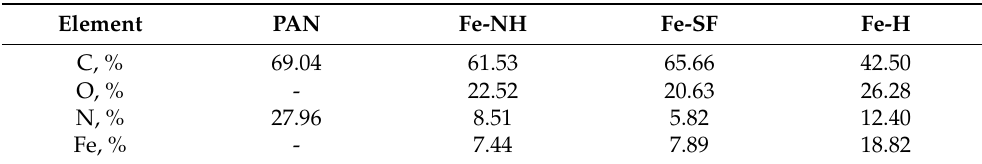
Table 2. Elemental composition of the surface of materials, obtained on an SEM equipped with an EDS attachment.